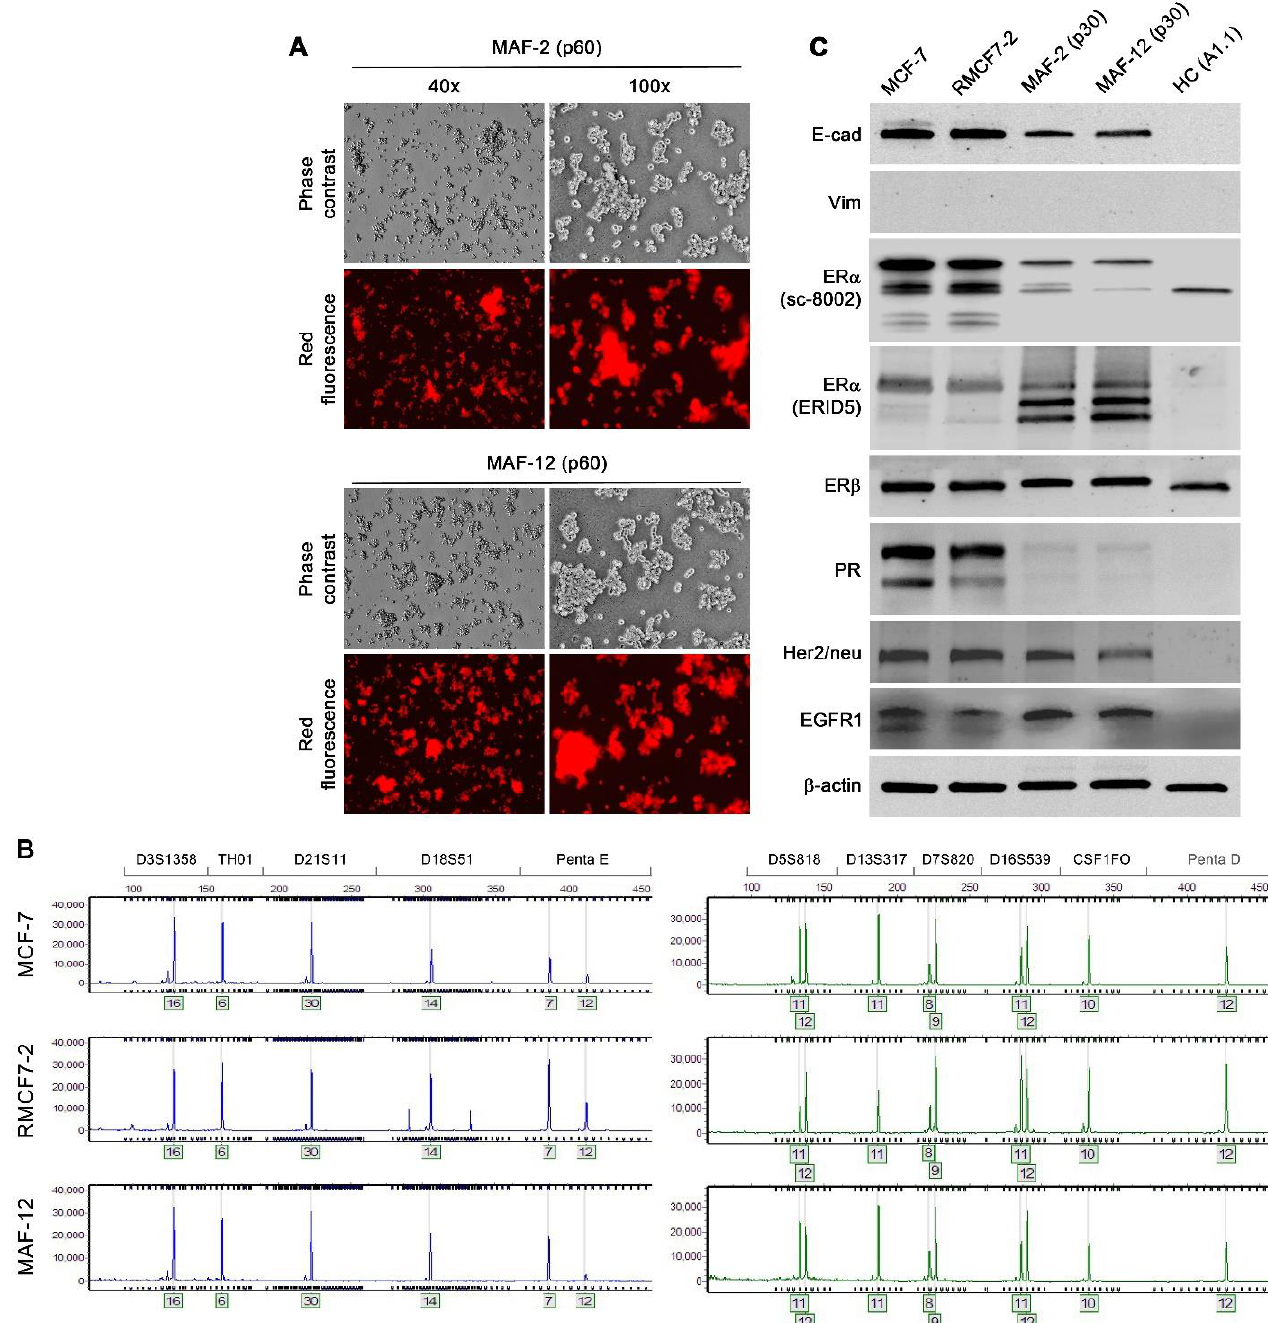
Figure 4. Stability of morphologic, growth behavioral and gene expressional changes. Representative results are shown. ( A ) MAF-2 and MAF-12 clones isolated from RMCF7-2 co-culture with breast cancer patient PBMCs were subjected to continuous culture in a 1:5 replating ratio. Cell images were taken at passage 60 (p60). The HC-like morphology and suspension growth behavior described in Figure 2 were well preserved throughout the passages. ( B ) Genotypic identity of MAF-12 to RMCF7-2 and MCF-7 cells. Cells of the MAF-2 clone carried the same STR profiles. Including the results not shown, all the 18 STR loci analyzed were identical among these cells. ( C ) Altered marker protein expression in MAF-2 and MAF-12 clones at p30. The expressional changes were stable since similar results were obtained with MAF-2 and MAF-12 clones at p60. For comparison, murine T cell hybridoma A1.1 cells were used as an HC